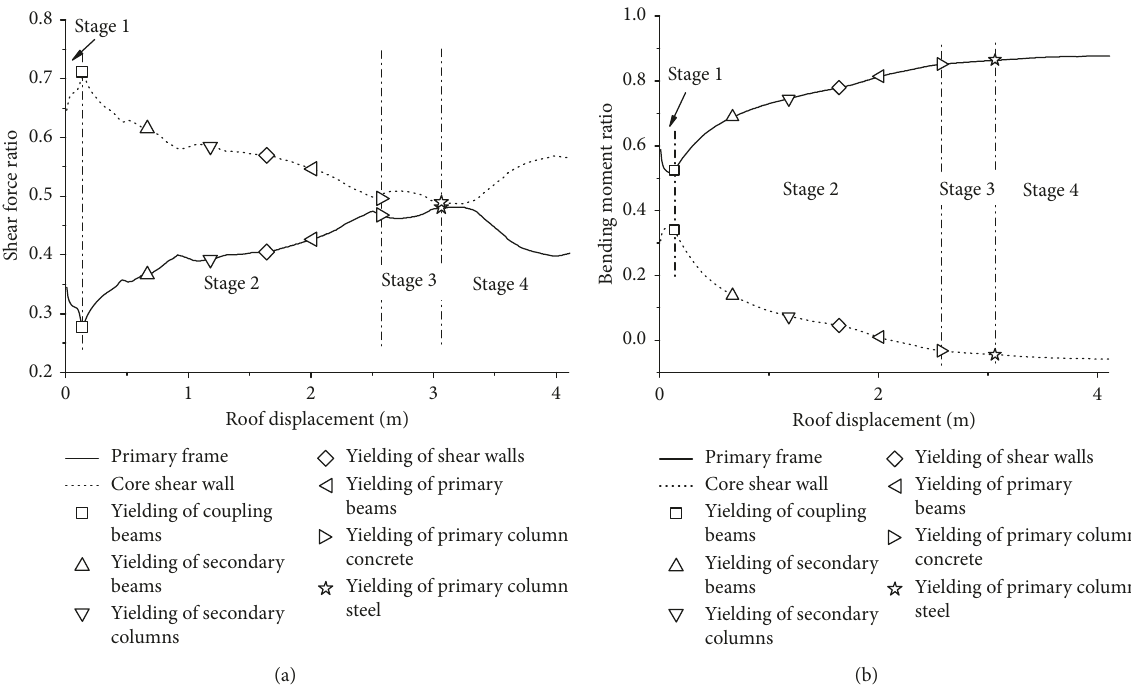
Figure 15: Internal force coefficient of model 5MC: (a) shear force ratio; (b) bending moment